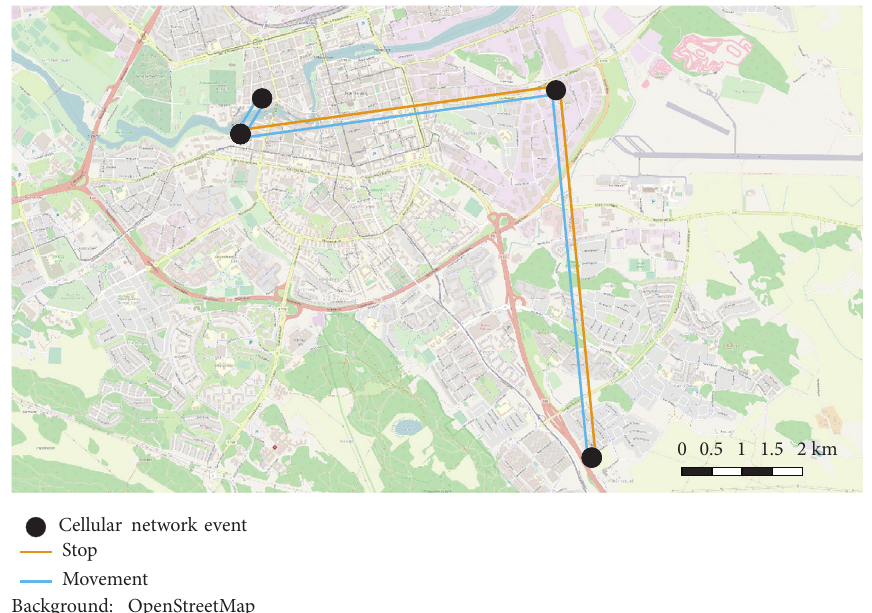
Figure 1: Example of trips extracted for one user starting southeast and ending northwest. The black dots are the positions of the antennas the user is connected to during the trip.